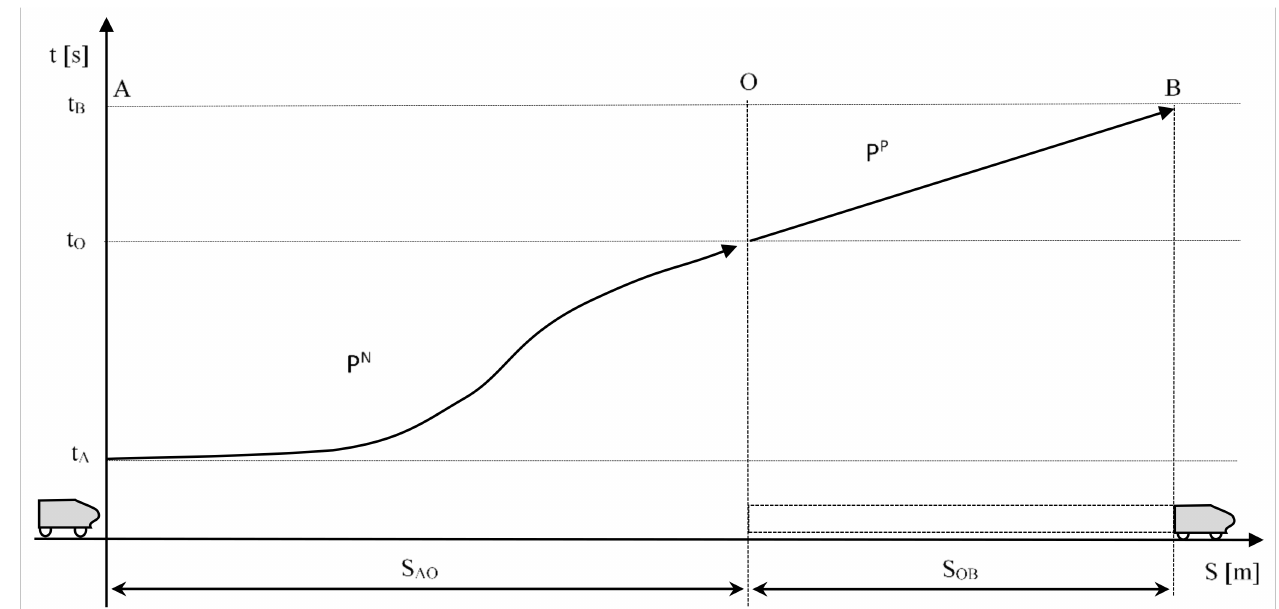
Figure 4. Striving for speed equalization between trains (source: own